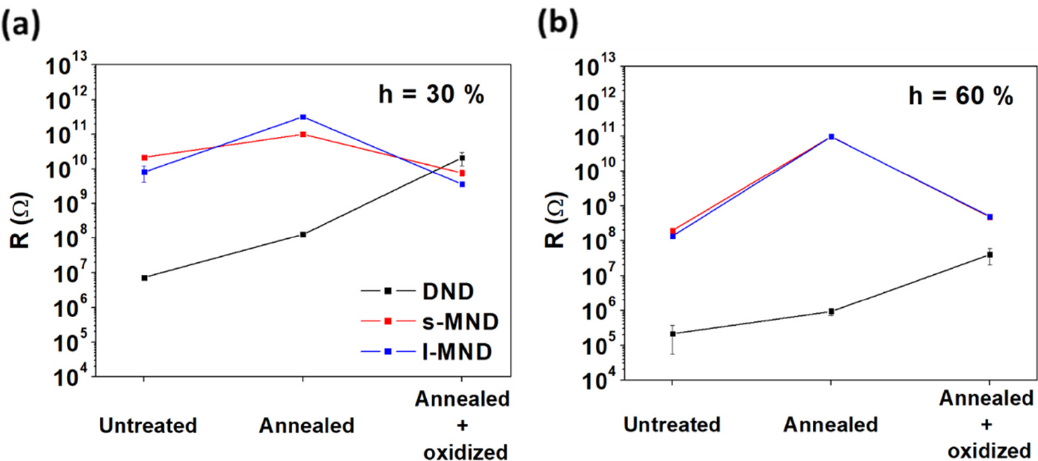
Figure 4. Electrical resistance of NDs at the different processing steps after 15 h exposure to 30% ( a ) and 60% ( b ) humidity.